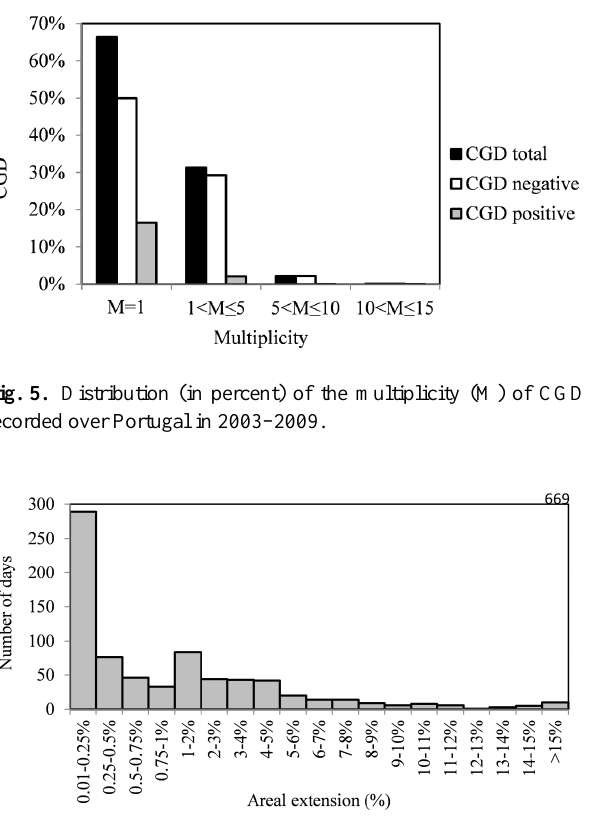
Figure 6. Distribution of the number of AEDCGD days as a function of the areal 670 Fig. 6. Distribution of the number of CGD days as a function of the extension (%) of CGD detection over total area of occurrence over Portugal in 2003- 671 areal extension (%) of CGD detection over Portugal in 2003–2009 2009 (1% of total area corresponds to approximately 28 grid cells). 672 (1% of total area corresponds to approximately 28 grid 673